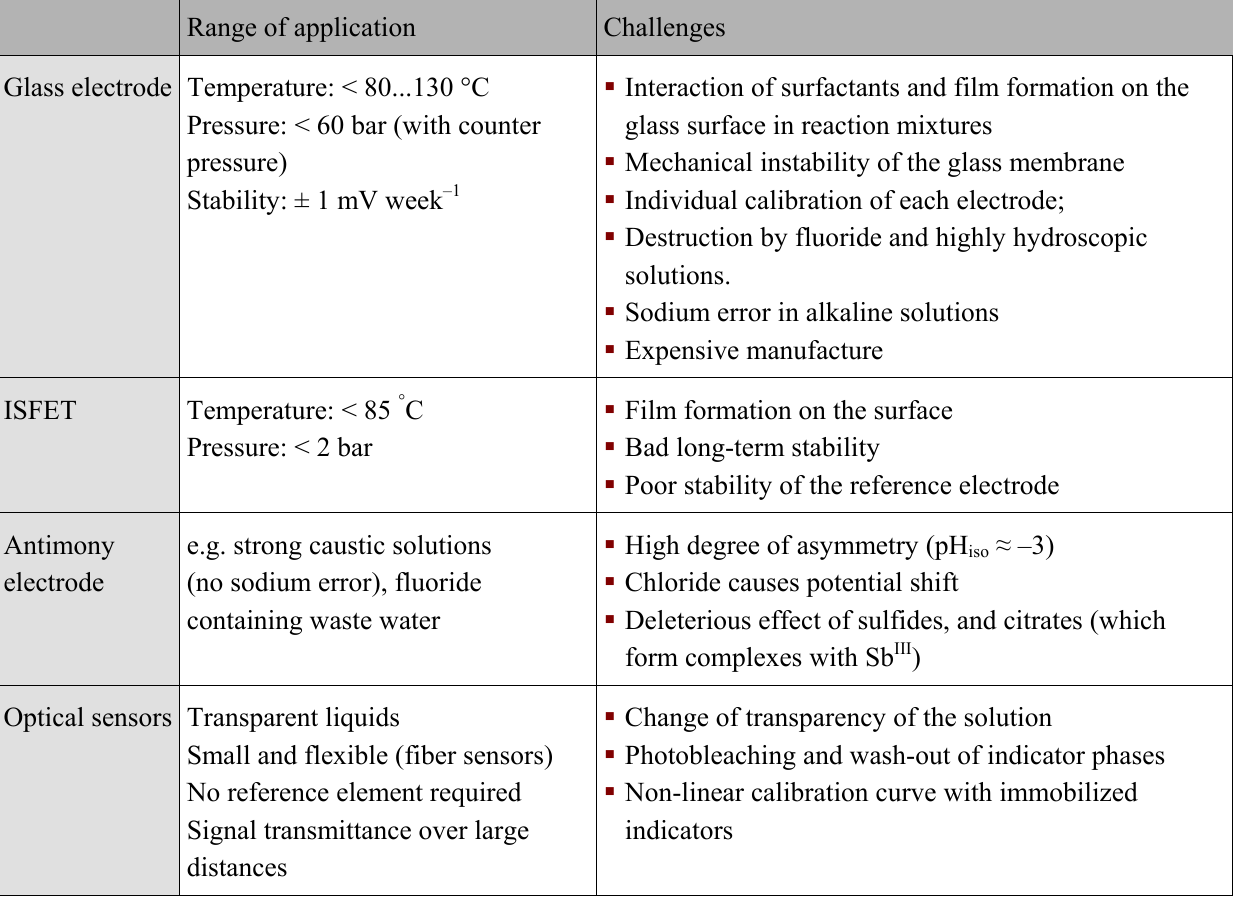
Table 2. Specific advantages and drawbacks of different pH measuring